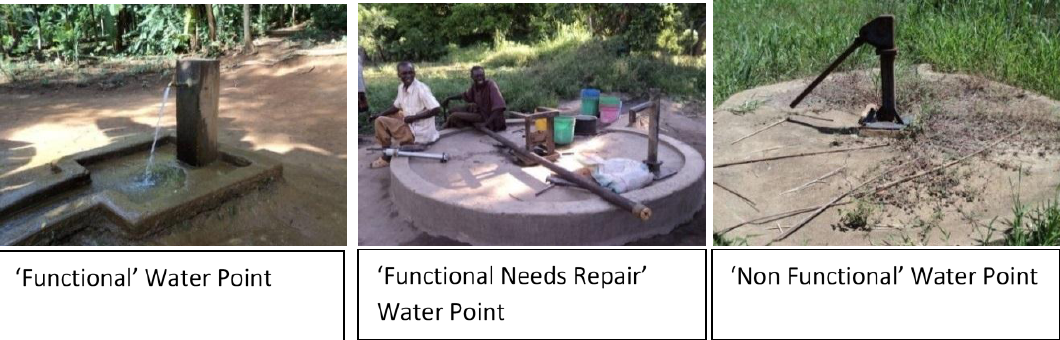
Figure 1. Images of rural water points with different functionality status adapted from [11].